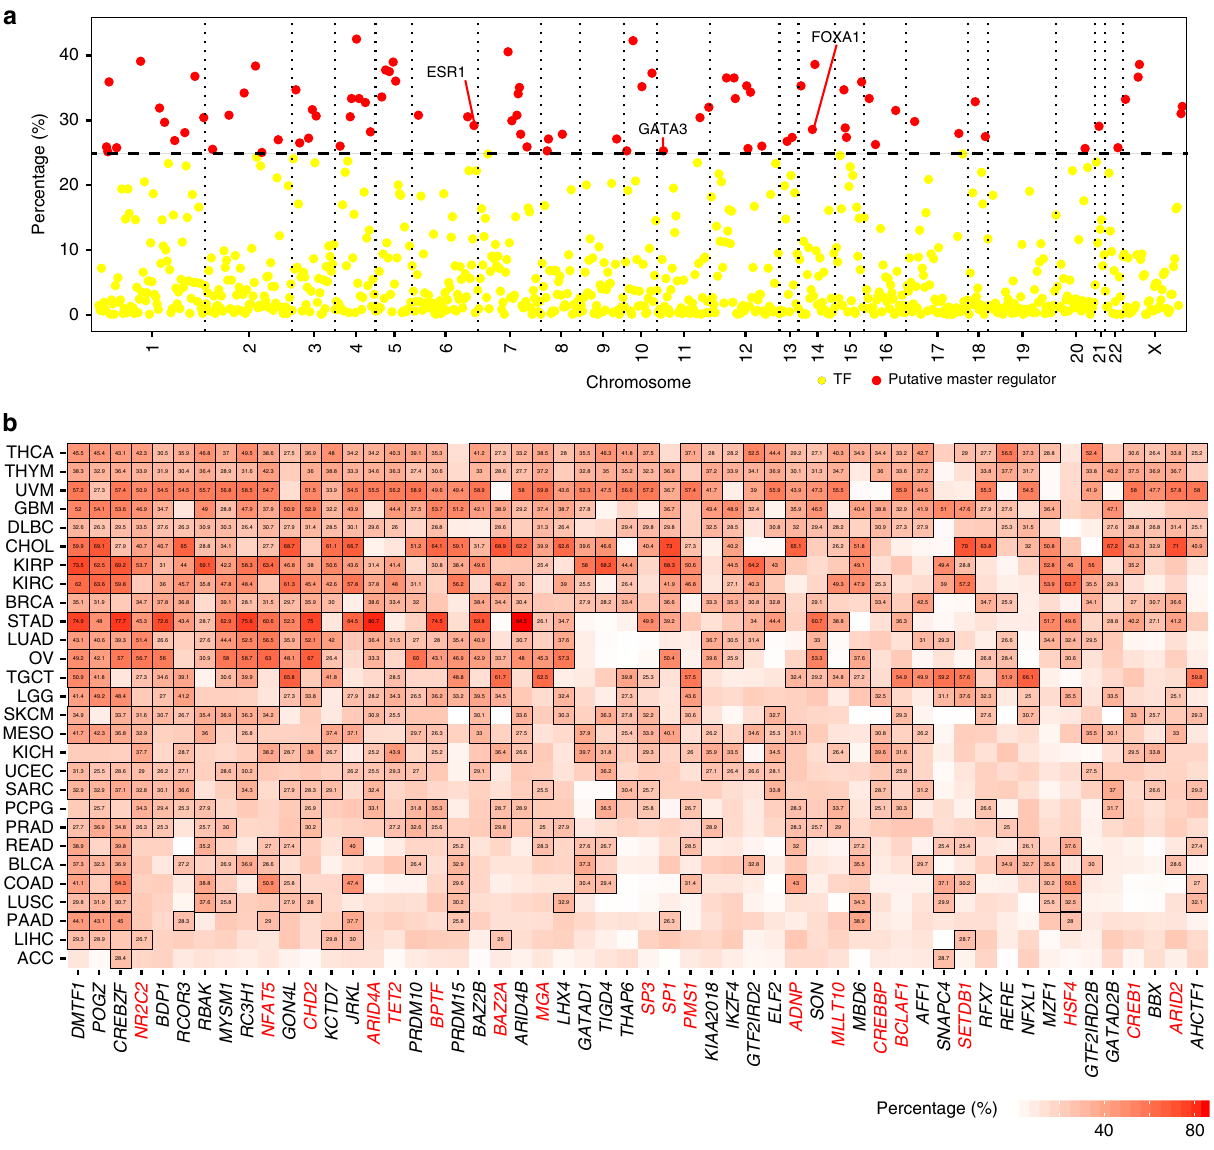
Fig. 2 Putative regulation of eRNA biogenesis in cancer. a Putative regulators of eRNAs in BRCA. Each dot represents one transcription factor (TF). Red dots denote putative master regulators signi fi cantly correlated to ≥ 25% of individual eRNAs. Three well-known TFs ( ESR1 , GATA3 , and FOXA1 ) are highlighted. X -axis is chromosome; y -axis is percentage of eRNAs correlated to each TF. b General putative master regulators in human cancers. X -axis is symbol of putative master regulator and y -axis is cancer type. General putative master regulators involved in genomic instability are marked by red. Number in cells denotes the percentage of eRNAs regulated by each master regulator. Scale bar denotes percentage of eRNA correlated with TFs ( x axis) across cancer types ( y